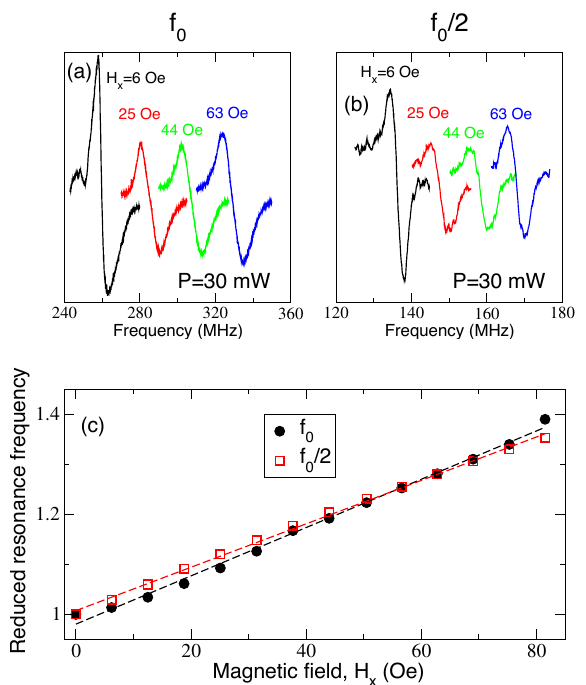
Figure 3. Experimental in-plane magnetic field dependence of the nonlinear DW resonances. (a) Fundamental DW resonance, (b) subharmonic Bloch DW resonance at f 0 / 2. The input mi- crowave power is fixed at P = 30 mW. (c) In-plane field de- pendence for the reduced resonance frequencies of fundamental and subharmonic DW resonances. The resonance frequencies are normalized by those at zero-field. The dashed lines correspond to linear regressions.